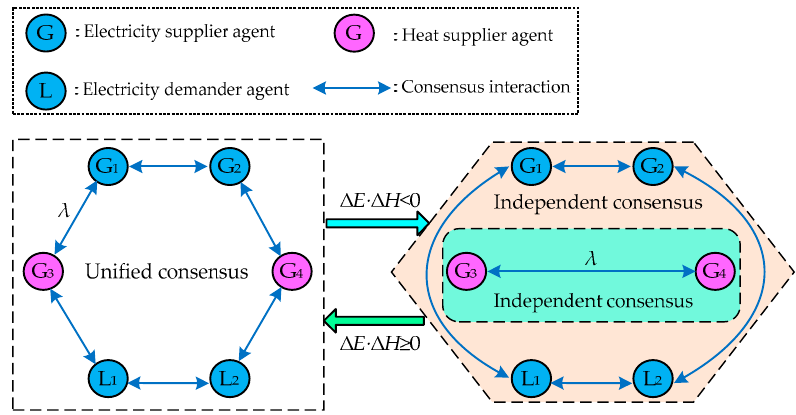
Figure 5. Principle of adaptive consensus algorithm.